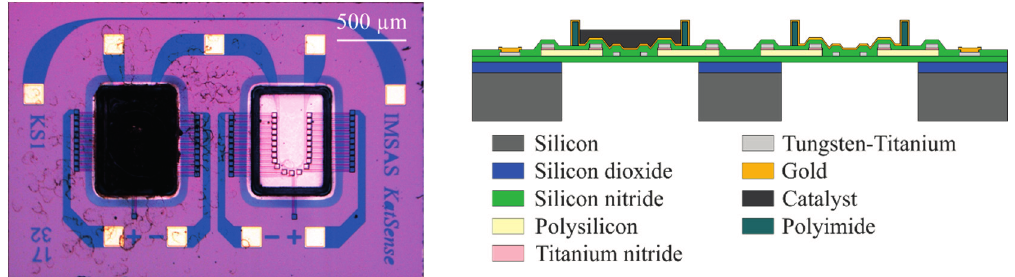
Figure 1. Microscope picture of the sensor ( left ) and a scheme of the sensor structure and materials ( right ).